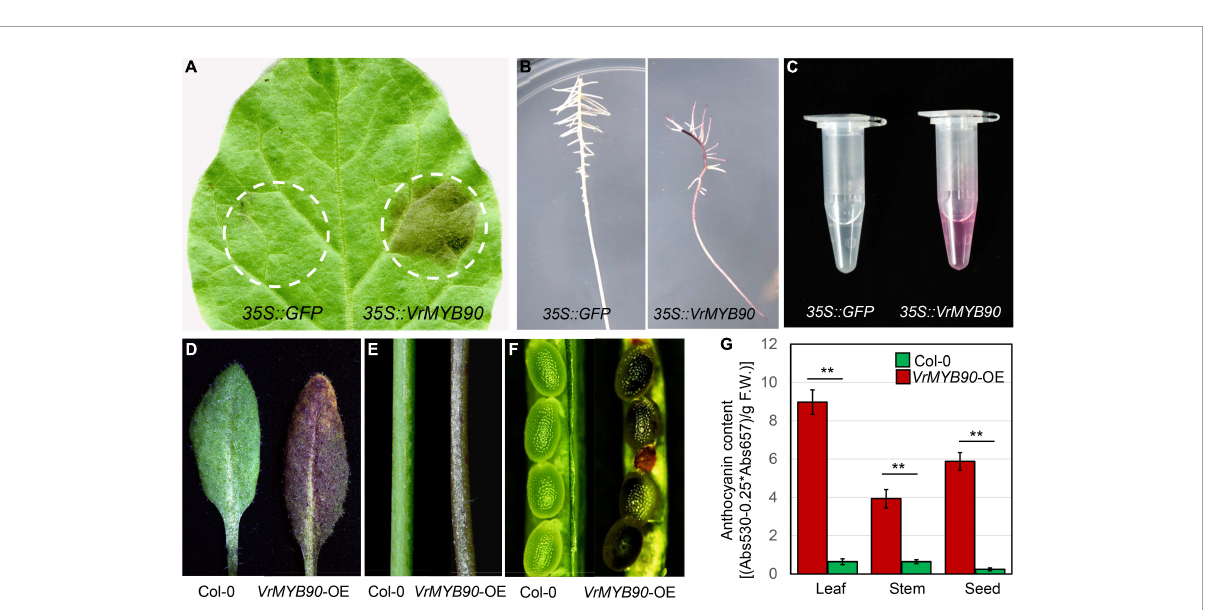
FIGURE4 Functional validation of VrMYB90 . (A) Color changes induced by transient expression of 35S::VrMYB90 in N . tabacum leaves (right) at 5 days after infiltration. 35S::GFP was used as a negative control (left). Dotted circles indicate infiltrated positions. (B) Transient expression of 35S::VrMYB90 induces color changes in mungbean hairy roots. 35S::GFP was used as a negative control. (C) Fresh extracts from the hairy root in (B) . (D–F) Color changes induced by overexpression of 35S::VrMYB90 in leaf (D) , stem (E) , and seeds (F) of A. thaliana . (G) The anthocyanin content in different tissues of transgenic A. thaliana . **Indicates a significant difference by Student’s t -test ( P <